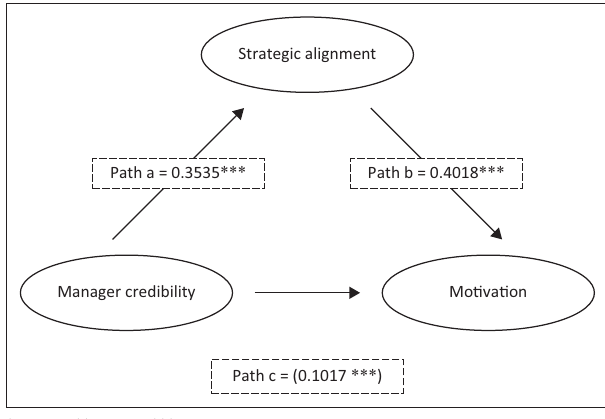
FIGURE 1: Mediation model – predictor variable (manager credibility), outcome variable (motivation) and mediator variable (strategic alignment).